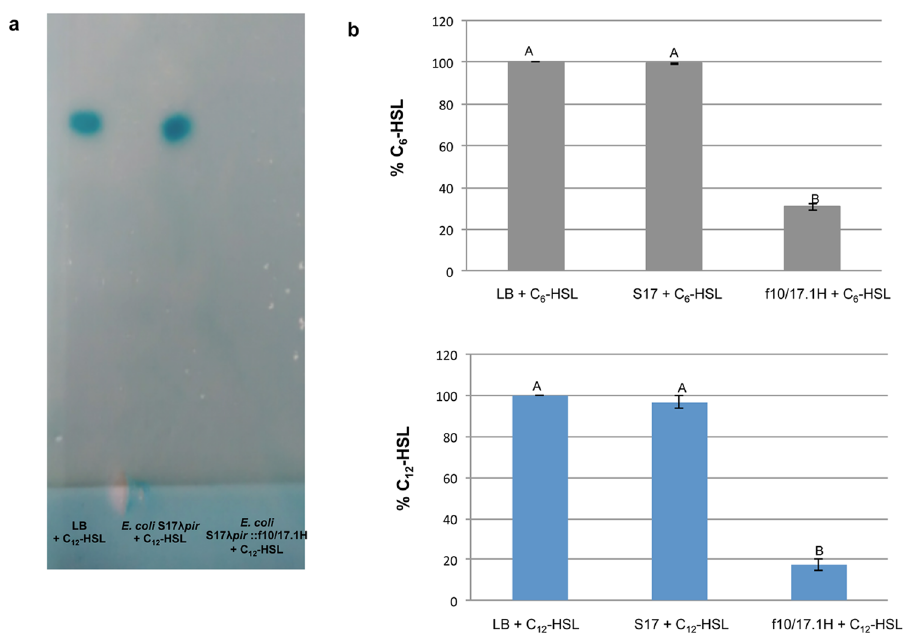
Figure 2. Confirmation of AHL-degradation activity. ( a ) TLC analysis using the biosensor Agrobacterium tumefaciens NTL4 (pZLR4). ( b ) HPLC/MS measurements of remaining C 6 -HSL and C 12 -HSL after 24 h incubation with E . coli S17 λ pir and E . coli S17 λ pir ::f10/17.1H. LB medium was used as control. Initial AHL concentration was 25 µ M. Error bars represent standard deviations. Different letters above the bars indicate that the values are significantly different according to a one-factor (treatment) ANOVA (P < 0.05) and the Tukey